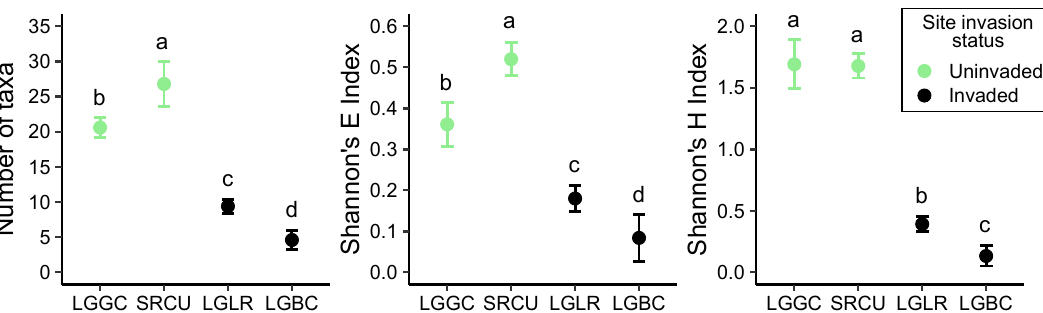
Figure 1. The effects of Ludwigia hexapetala (LUHE) invasion on biodiversity components of the plant community (mean ± SE) including species richness (number of taxa), evenness (Shannon’s E ), and diversity (Shannon’s H’) at Laguna at Gravenstein Creek (LGGC), Santa Rosa Creek above Laguna (SRCU), Laguna at Laguna Ranch (LGLR), and Laguna at Blucher Creek (LGBC). Data points represent means with standard error bars.